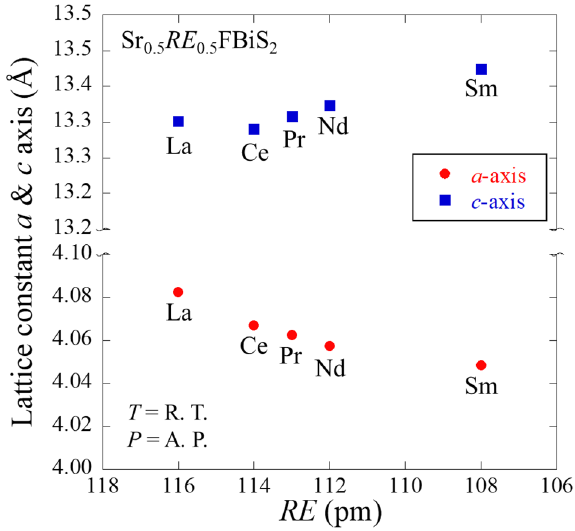
Figure 2. Dependences of the lattice constants a and c as a function of the RE 3+ ( RE : La, Ce, Pr, Nd, and Sm) ionic radius.